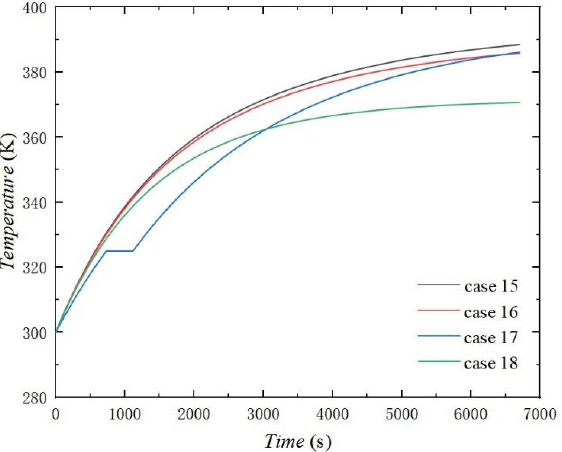
Figure 23. The diagram of combined thermal protection for the casing, baffle and accessory.